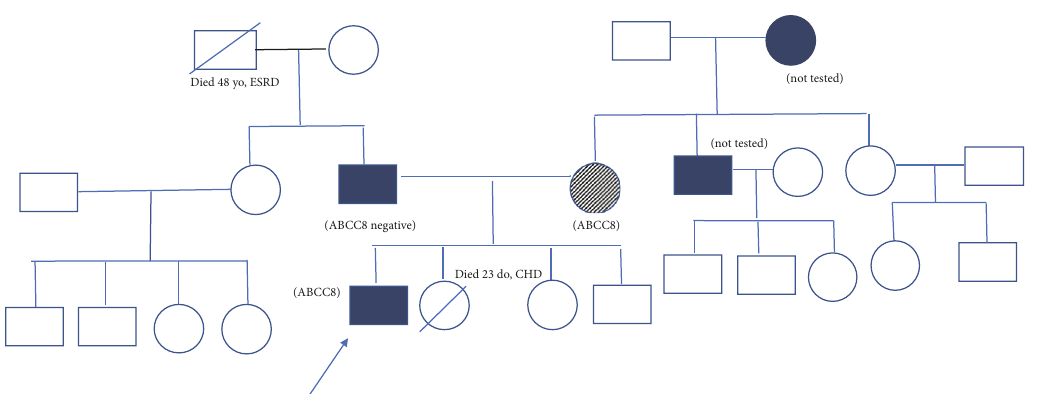
Figure 1: Pedigree chart of the described